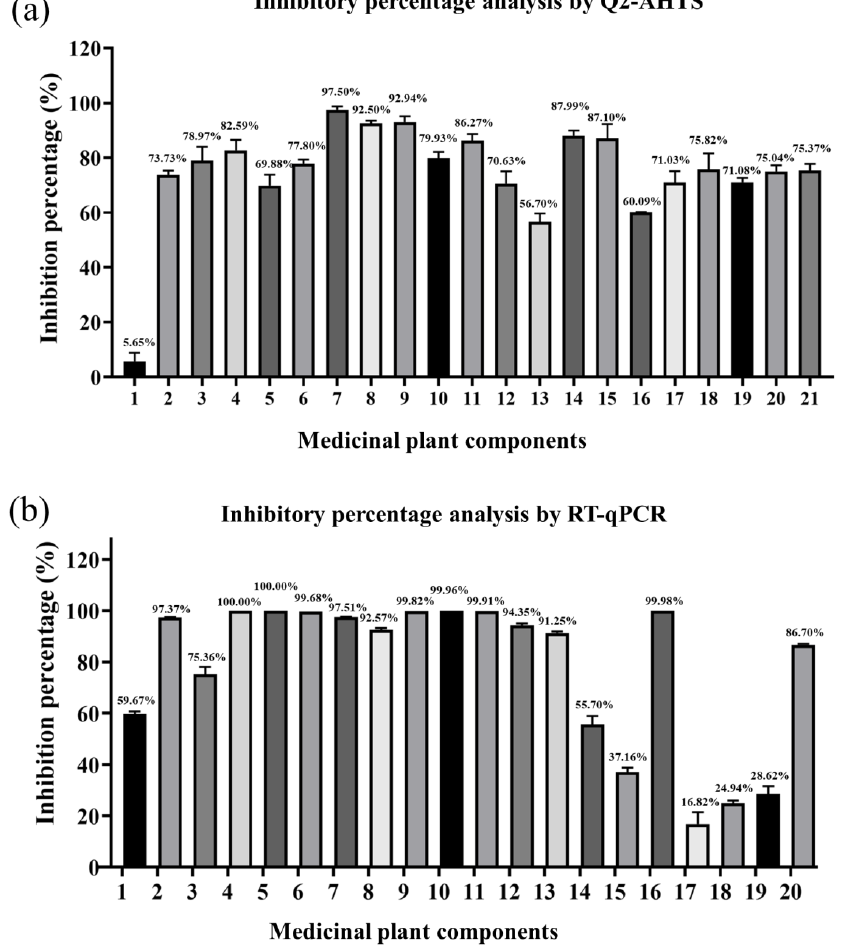
Figure 5. Antiviral analysis of 20 medicinal plant components against SGIV infection. RT-qPCR showed that the expression of MCP gene decreased after treatment with components 1 – 20. Results are presented as mean ± SD of three independent experiments (** p < 0.01).